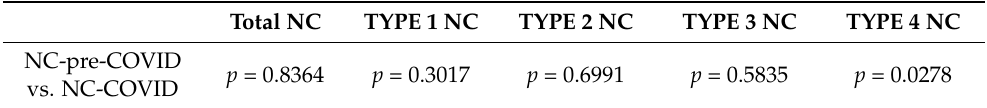
Figure 1. Boxplot with statistical summary obtained from the distribution of the individual classes of non-conformities (NC); ( a ) NC Type 1; ( b ) NC Type 2; ( c ) NC Type 3 and ( d ) NC Type 4. The central box shows the values from the 25th to the 75th quartile, the central line the median, the horizontal lines the extension from the value. Table 2. Comparison of the difference between the means of total NC or differentiated according to the type encountered in the pre-COVID vs. COVID periods (Mann–Whitney